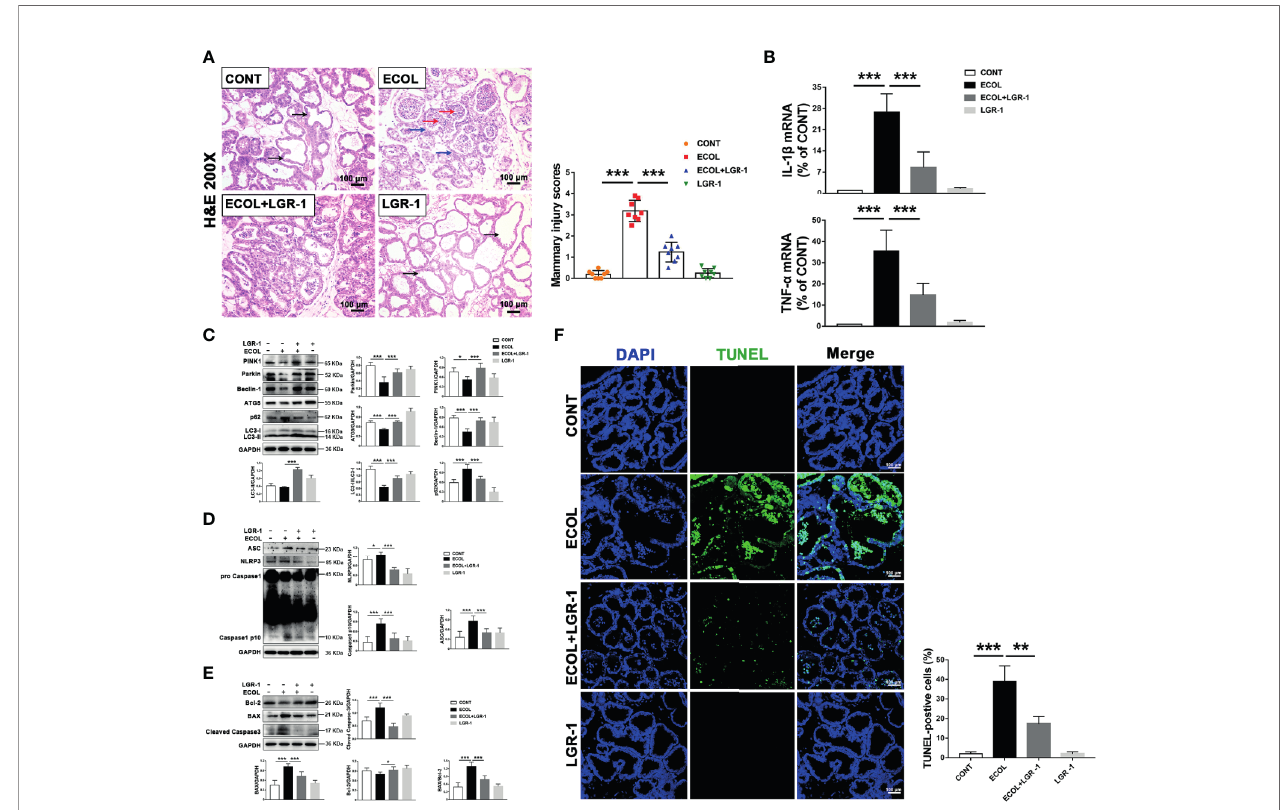
FIGURE 9 | LGR-1 alleviates E coli -induced mitophagy inhibition, NLRP3 in fl ammasome activation, and apoptosis in mice mammary gland. (A) Mammary gland tissue sections were stained with H & (E) The black arrow was the normal tissues. The red arrow was the in fi ltration of in fl ammatory cells. The blue arrow was the hyperplastic of alveolar wall. The scoring criteria are varying from 0 points to 4 points in no injury, mild injury, moderate injury, severe injury, and extreme injury, respectively. Scale bar, 100 µm. (B) The mRNA levels of IL-1 b and TNF- a in mammary tissue homogenate. (C, D, E) Western blot analysis of PINK1, Parkin, Beclin- 1, ATG5, p62, LC3, ASC, NLRP3, Caspase-1, BAX, Bcl-2, and cleaved Caspase-3. The right and lower panel shows the protein quanti fi cation using ImageJ software (version 1.50). (F) Apoptosis was accessed by TUNEL staining of mammary and quanti fi cation of TUNEL-positive cells. DAPI (Blue, nucleus). Scale bar, 100 µm. LGR-1 was given by gavage (2.5 × 10 8 CFU/200 m L saline, 7 consecutive days, once a day), and then E coli (1 × 10 6 CFU/30 m L saline) was injected into mammary duct to establish a mouse mastitis model (24 hours later, the mice were euthanized and mammary tissue was collected). Data presented are mean ± SEM; n = 8. * p < 0.05, *** p <